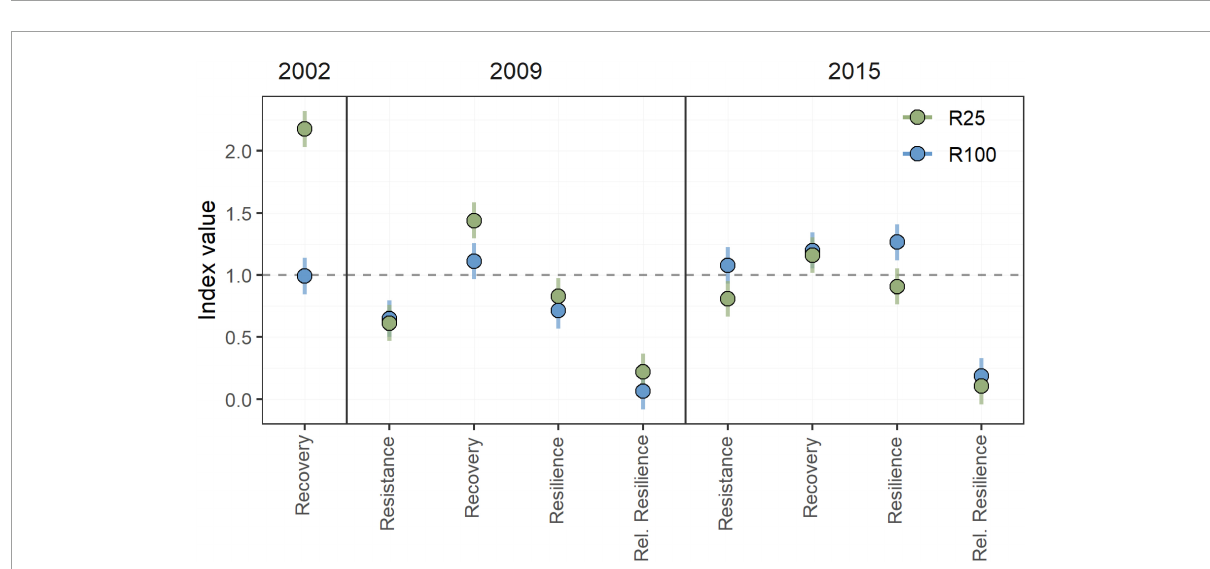
FIGURE5 Comparison of drought indicators for the 25% retention treatment (R25) and the no-treatment control (100% retention or R100) for three drought years: 2002, 2009, and 2015. The partial cutting treatment occurred in the winter of 2002/2003. Therefore, only recovery is included for 2002. Error bars indicate the 95th confidence